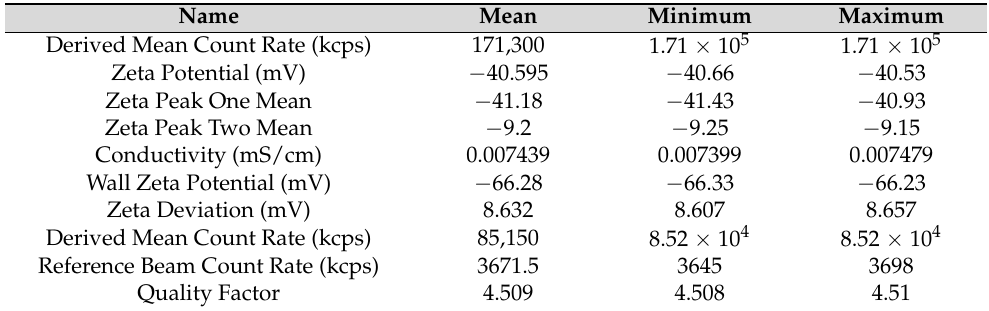
Figure 2. Size determination diagram of liposomes from the ’ Garlic-lipo ’ colloid. Liposome sizes are in the range between 134.2 and 164.2 nm. Table 2. Measurement of Zeta potential and quality of individual liposomes of the ’ Garlic-lipo ’ sam- ples.